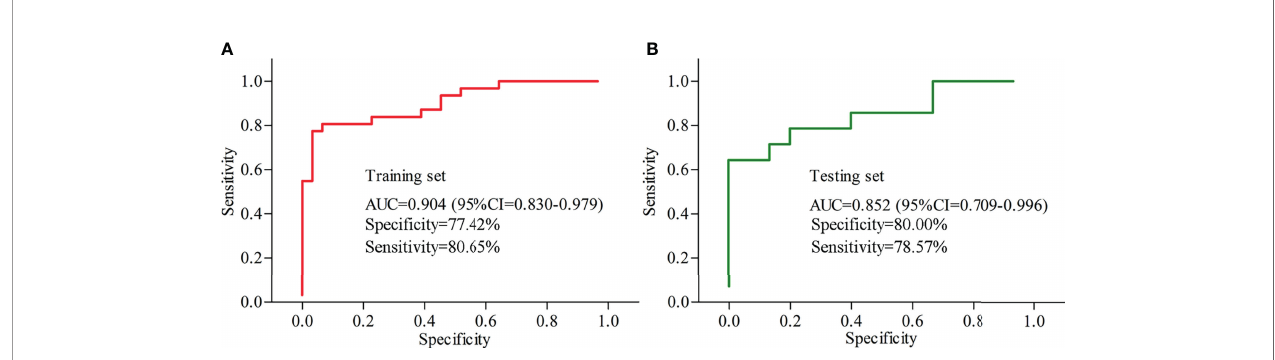
FIGURE 6 | Diagnostic performances of the identi fi ed potential biomarkers. (A) samples in training set were used to identify the potential biomarkers, and the AUC value showed that these biomarkers could effectively diagnose MDD; (B) samples in testing set were used to assess the diagnostic performance of these biomarkers, and the AUC value showed that these biomarkers could effectively diagnose independent MDD patients. AUC, area under the curve; CI, con fi